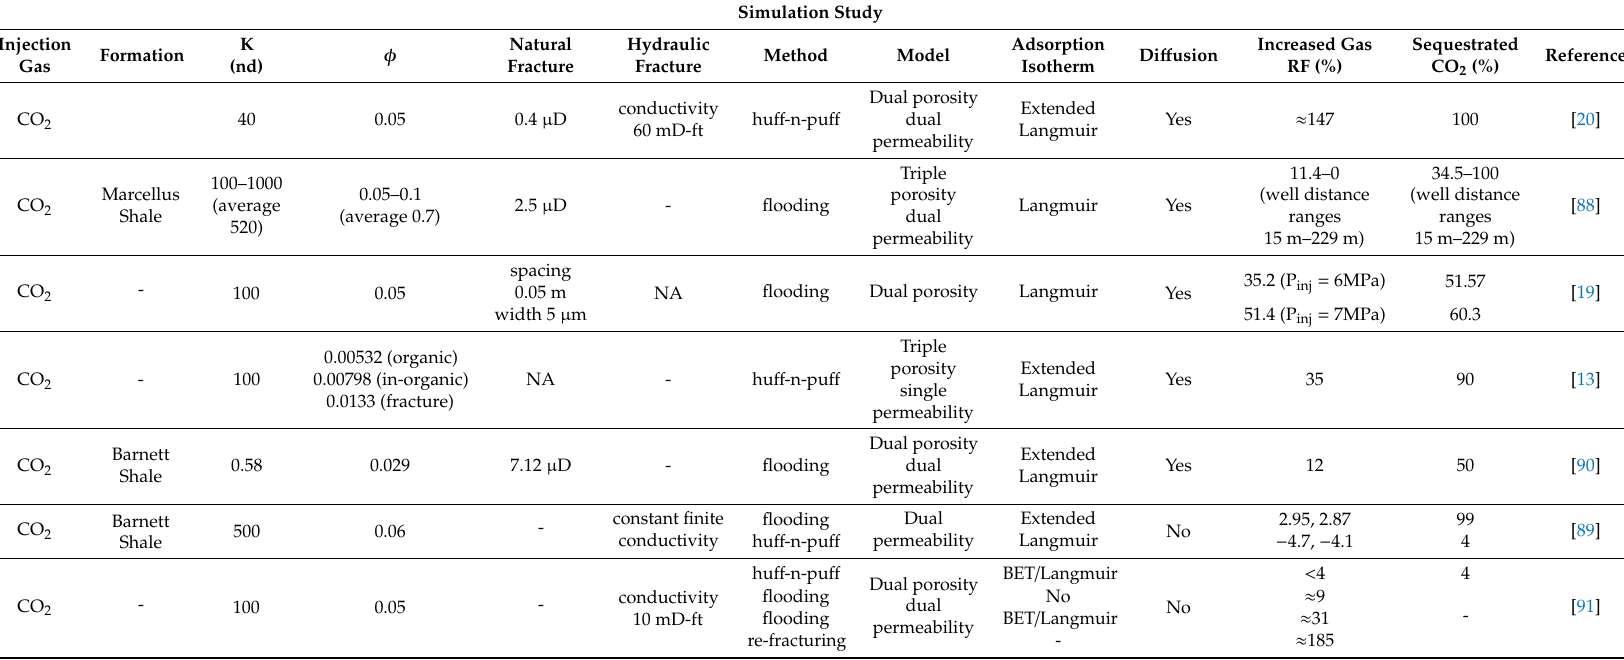
Table 4. The simulation studies about di ff erent gas injection approaches in shale gas reservoirs for